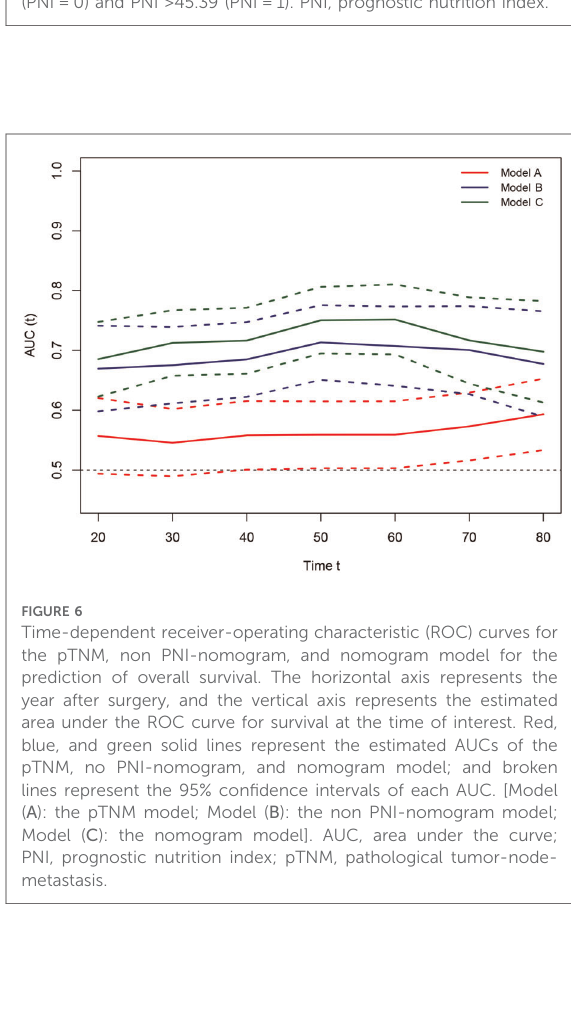
FIGURE 5 Kaplan-Meier analysis for overall survival (OS) of patients undergoing enhanced recovery after surgery combined with robotic radical gastrectomy according to the preoperative PNI. Red and lake blue solid lines represent Kaplan-Meier analysis for OS according to preoperative PNI ≤ 45.39 (PNI=0) and PNI >45.39 (PNI=1). PNI, prognostic nutrition index.